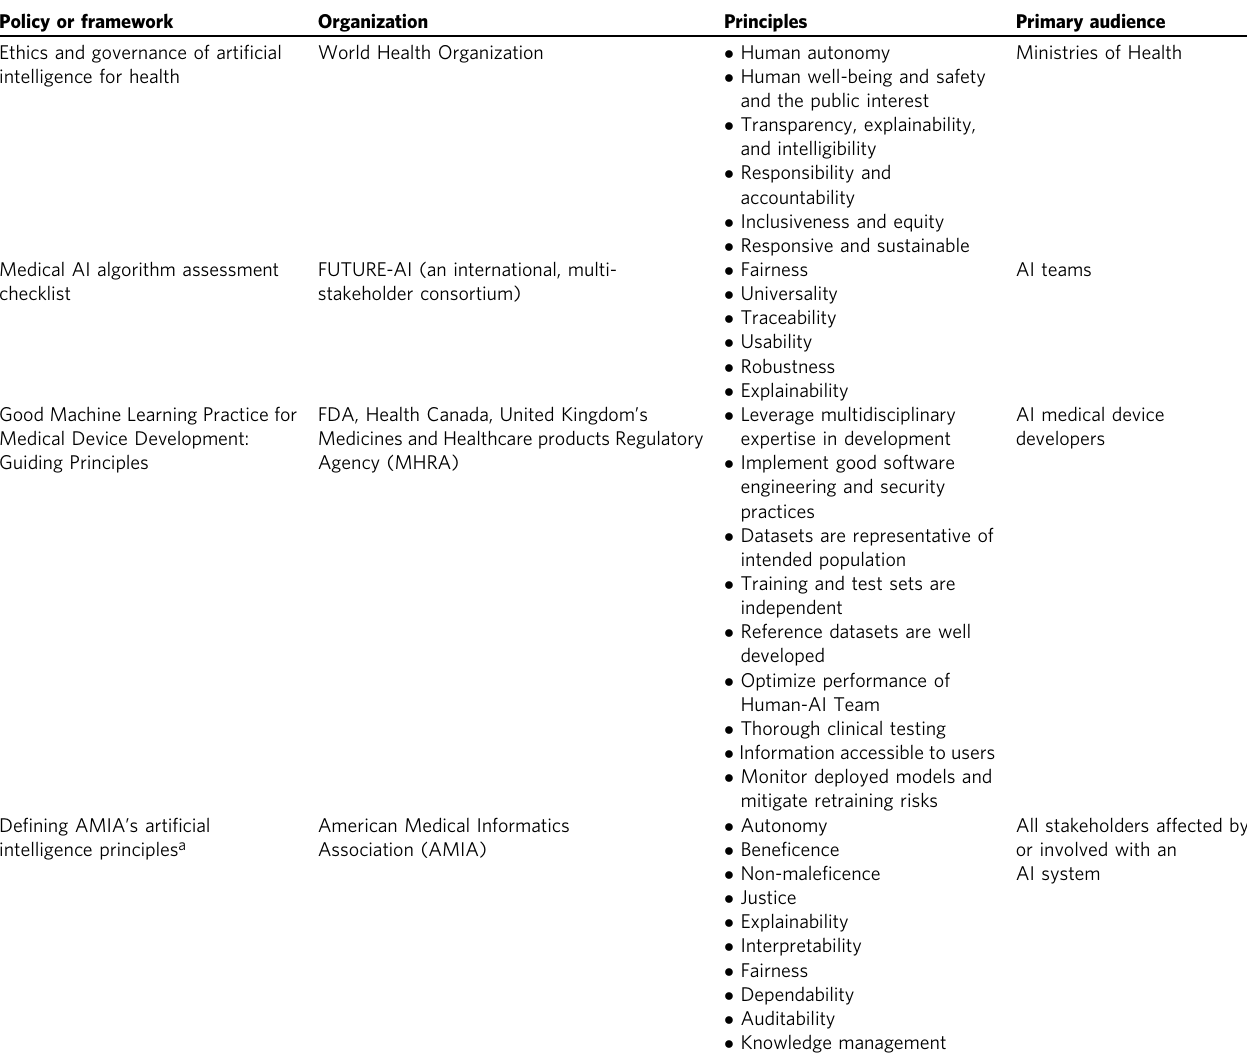
Table 1 Summary of AI principles proposed by select